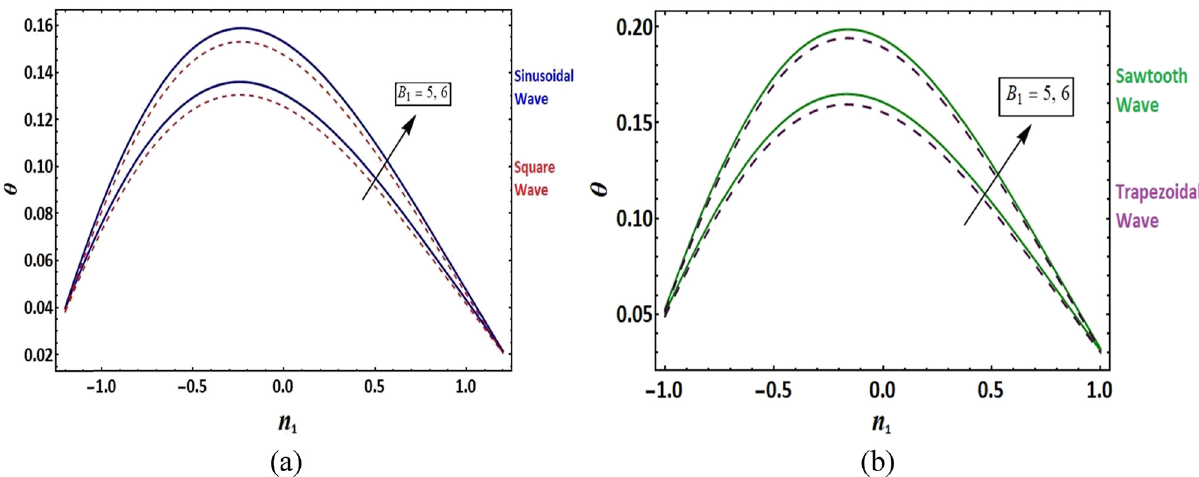
= 0.1, A = 2, Sr = 0.5, A = 1, Br = 0.5, K = 2, K = 3, ϵ 0.2 = , Gr 0.4 = , 1 3 3 1